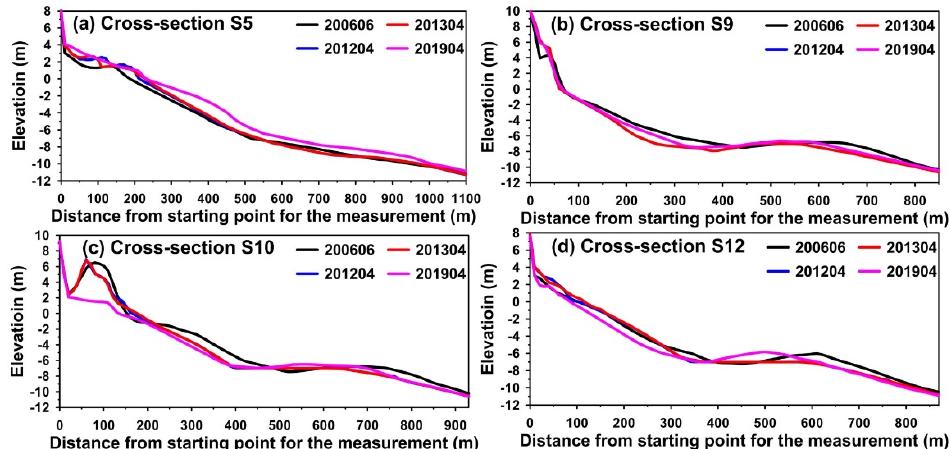
Figure 10. Cross-shore bathymetry profile comparisons for ( a ) S5, ( b ) S9, ( c ) S10, and ( d ) S12 cross- sections measured in various years.